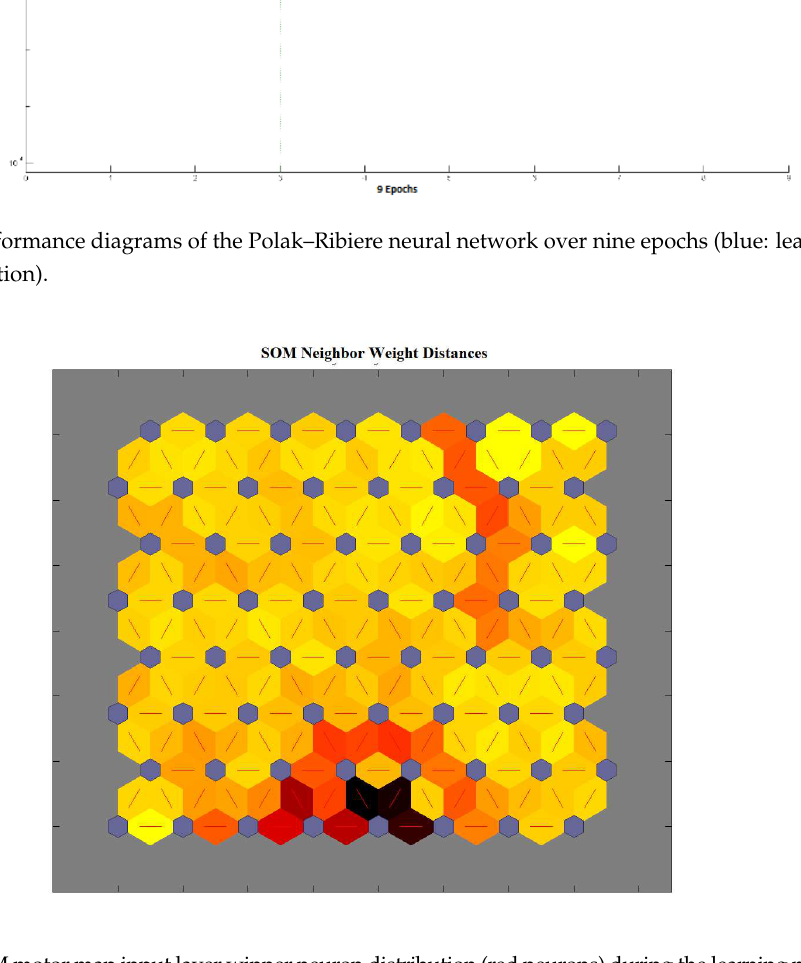
Figure 9. SOM motor map input layer winner neuron distribution (red neurons) during the learning